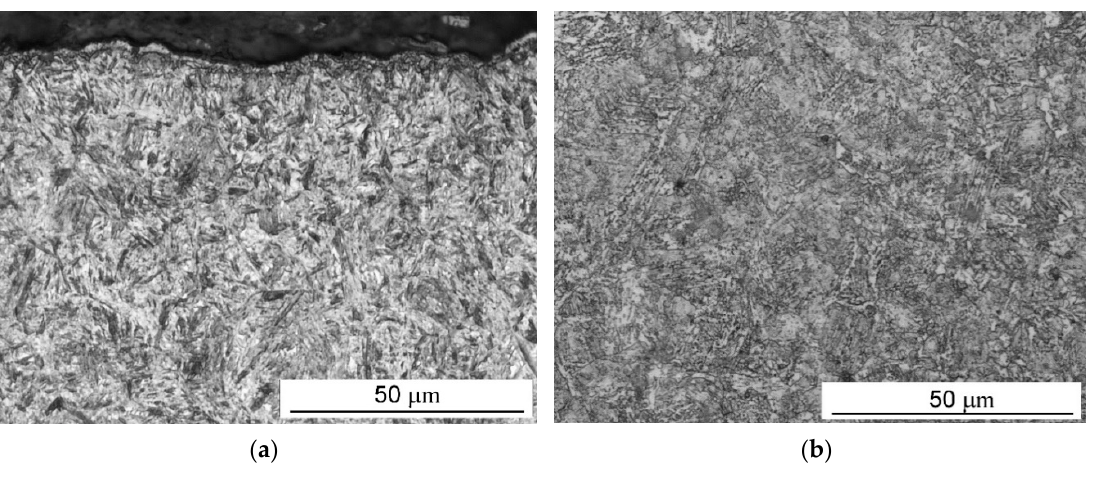
Figure 3. Structure of parts resulting from variable-flow process. ( a ) Surface of part . Structure: tempered martensite; retained austenite share below 10%. Magnification: ×400. Etching: 3% HNO 3 /ethanol; ( b ) Core of part. Structure: bainite. Magnification: ×400. Etching: 3% HNO 3 /ethanol.